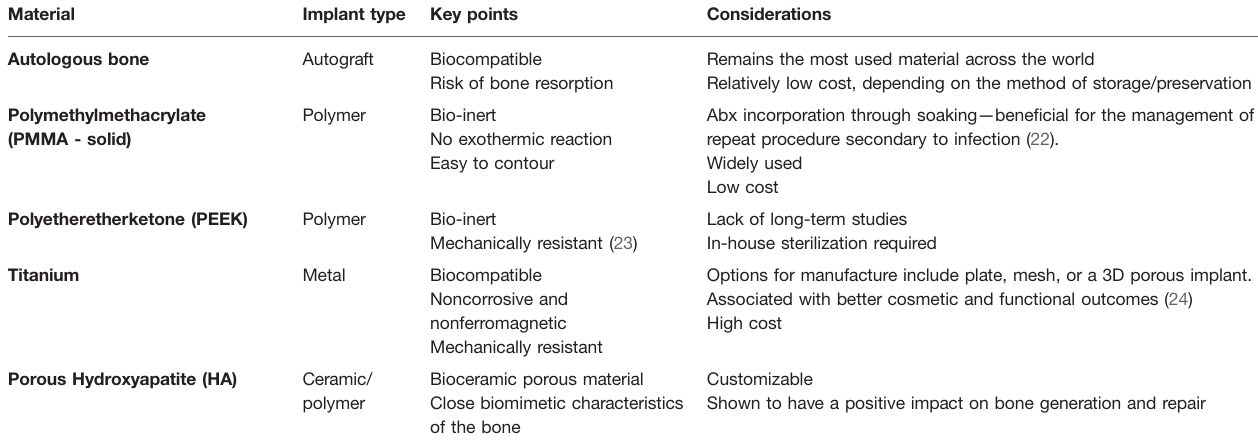
TABLE 1 | Summary of cranioplasty